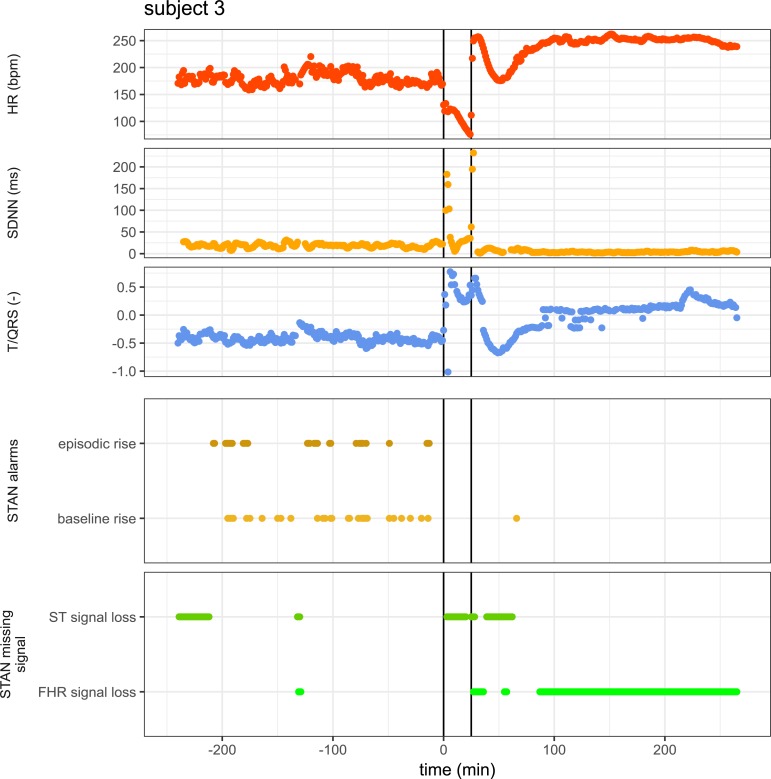
Example of failure of the STAN monitor to detect any ST-event during umbilical cord occlusion in subject 3.The top three panels show the calculated heart rate (HR), SDNN (estimate of HR variability) and T/QRS ratio from the fetal ECG as determined using our analysis technique as described [19]. The bottom two panels show STAN events and signal loss. The vertical lines indicate start and end of the umbilical cord occlusion. Note that during cord occlusion the STAN monitor indicated ST signal loss and no events were detected, despite calculated HR, SDNN and T/QRS ratio from the input ECG.